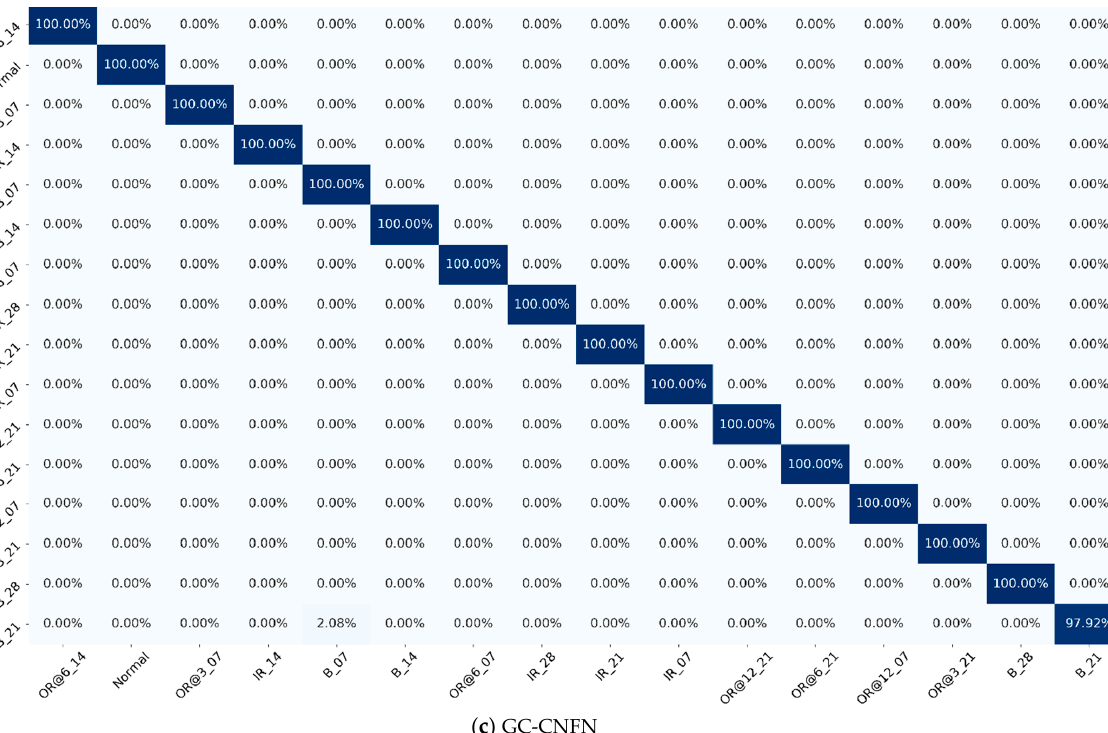
Figure 9. Confusion matrices of each model.